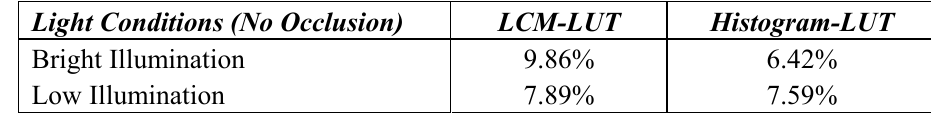
Table 2. Average relative error in the area estimate of red peaches for different illuminations.